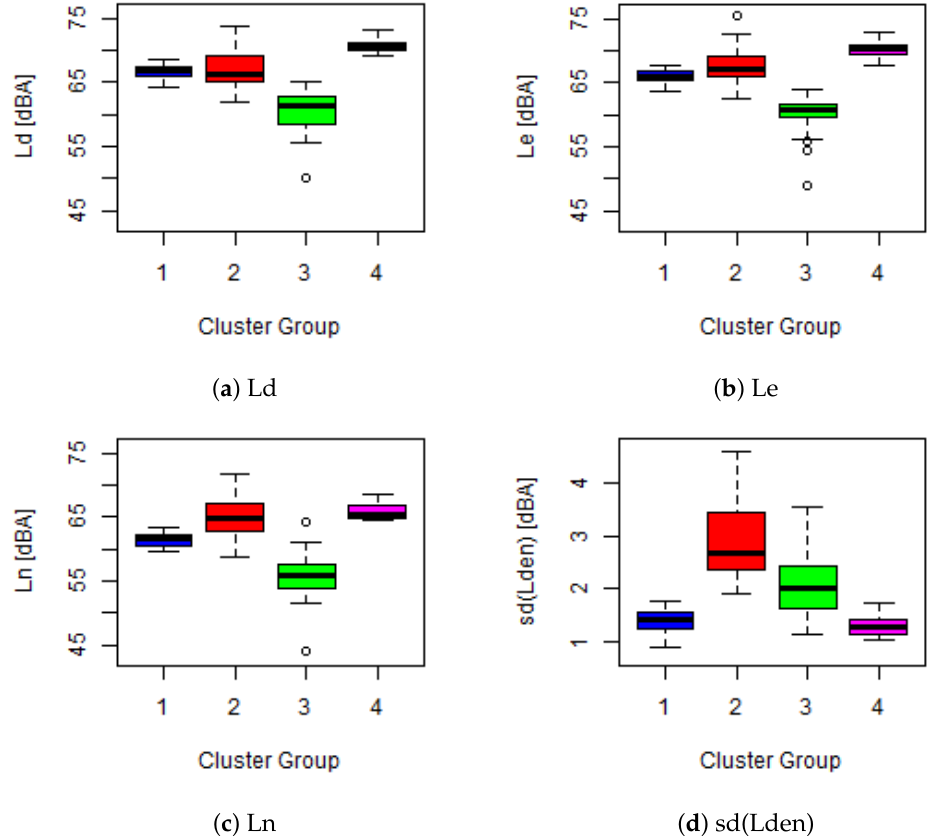
Figure 5. Boxplot representation of the statistical distributions of the variables L d2019 ( a ), L e2019 ( b ), L n2019 ( c ) and sd 2019 ( L den1 d ) ( d ) by cluster for k = 4. Hierarchical Agglomeration clustering model. Clusters groups are colored as presented in Table 7.